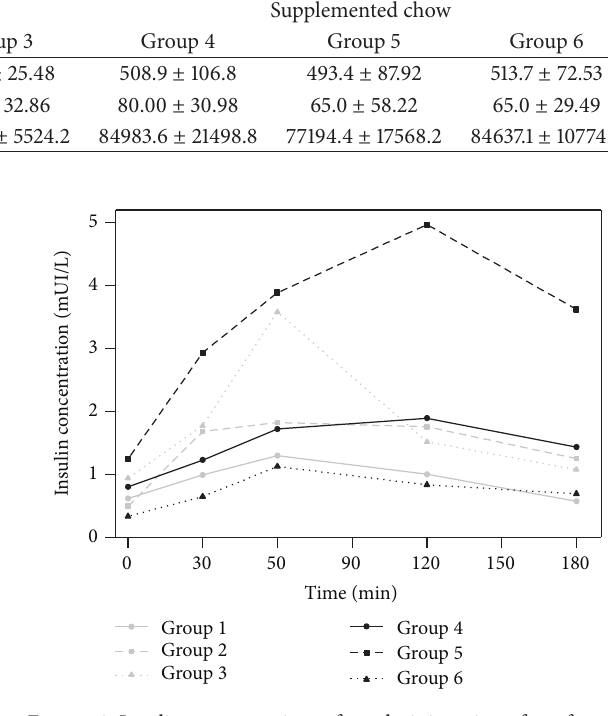
Figure 1: Glucose concentrations after administration of metformin (30 mg/kg) in the 6 groups studied. Group 1: control standard; group 2: oral metformin; group 3: oral metformin with Plantago ovata husk; group 4: control supplemented; group 5: oral metformin with supplemented chow; group 6: oral metformin with Plantago ovata husk with supplemented chow.